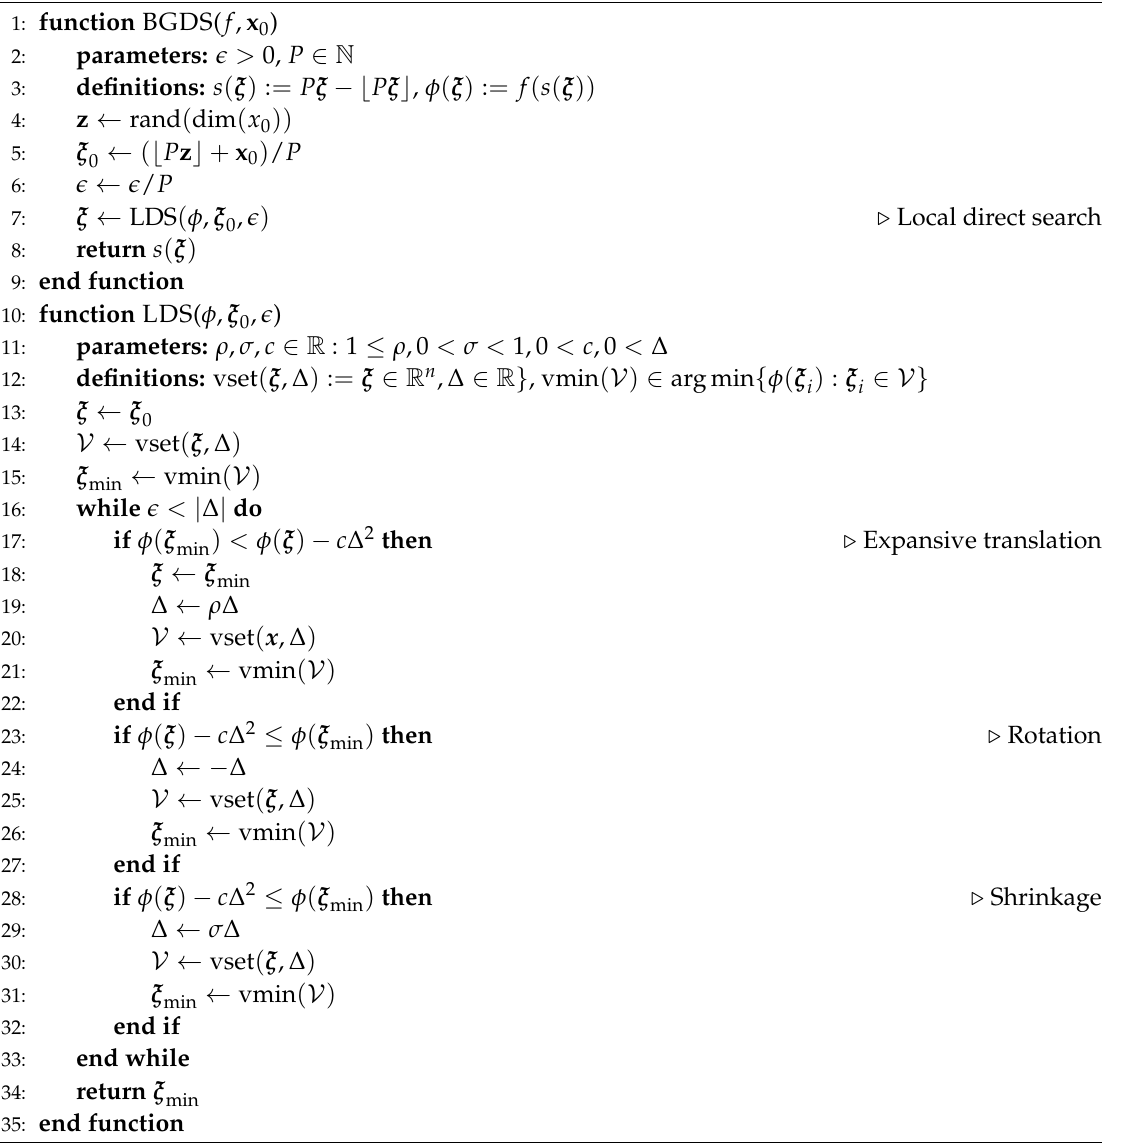
Algorithm 1 Basic